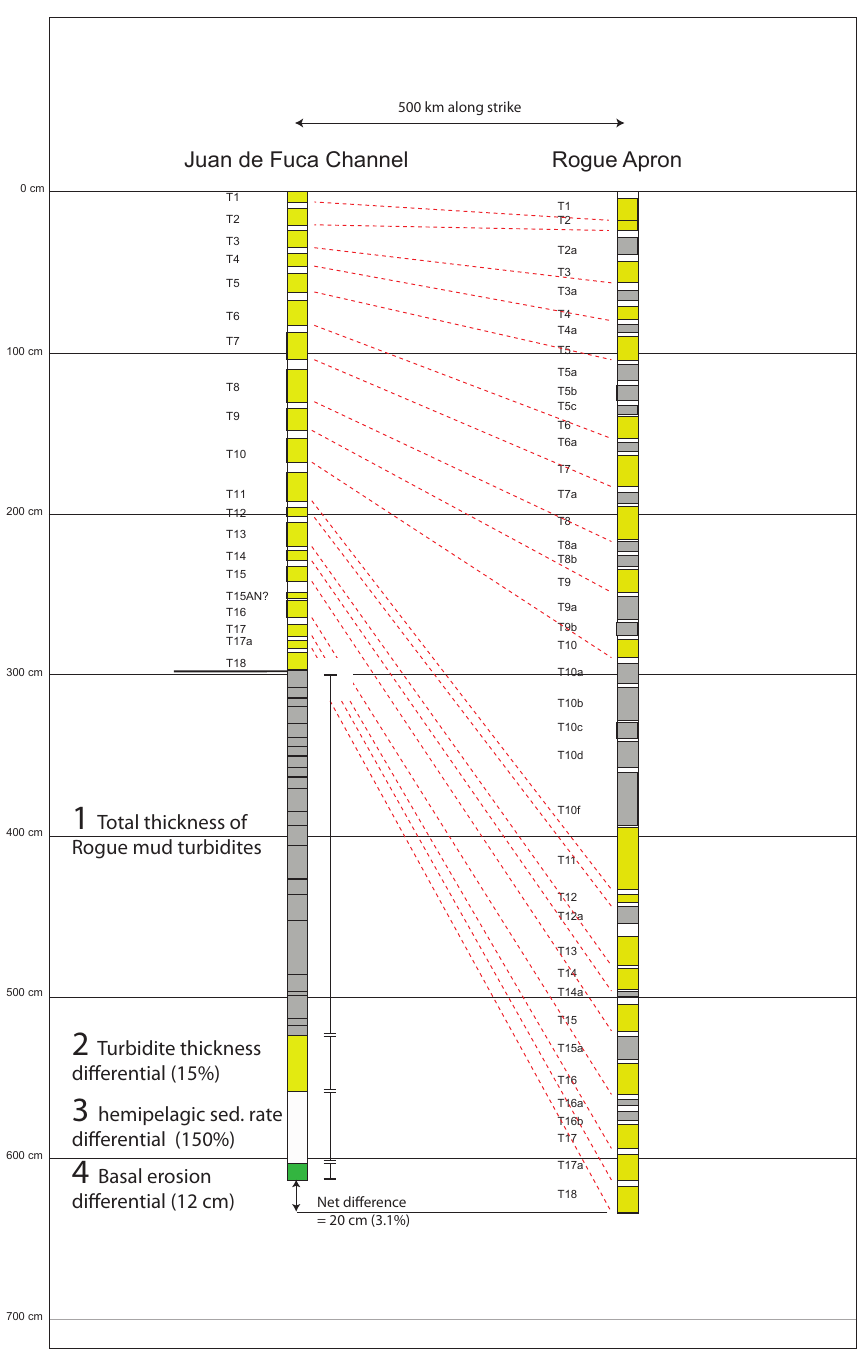
Fig. 11. Schematic comparison of stratigraphic sequences at the Juan de Fuca Channel and Rogue Apron at true scale. Major sandy turbidites for both cores are shown in yellow, mud turbidites shown in grey. Below the JDF core diagram, we add four units that represent the difference between the two sites. (1) The total thickness of mud turbidites from Rogue Apron; (2) the increased overall thickness of Rogue turbidites, 15% greater than JDF, is added to both mud and sand turbidites; and (3) the 150% difference in hemipelagic sedimentation rate (Goldfinger et al., 2012); and (4) the difference in basal erosion at the turbidite bases, compiled from Goldfinger et al. (2012). The net difference in Holocene section thickness is ∼ 22cm or 3.1%, with the greatest component of the section difference attributable to the presence of 23 southern Cascadia turbidites present at Rogue